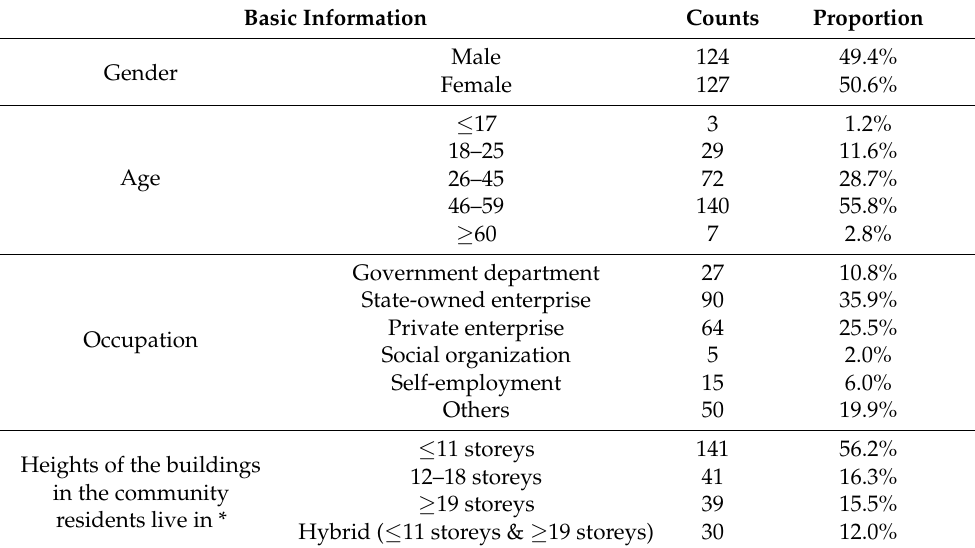
Table 3. Basic information of respondents.